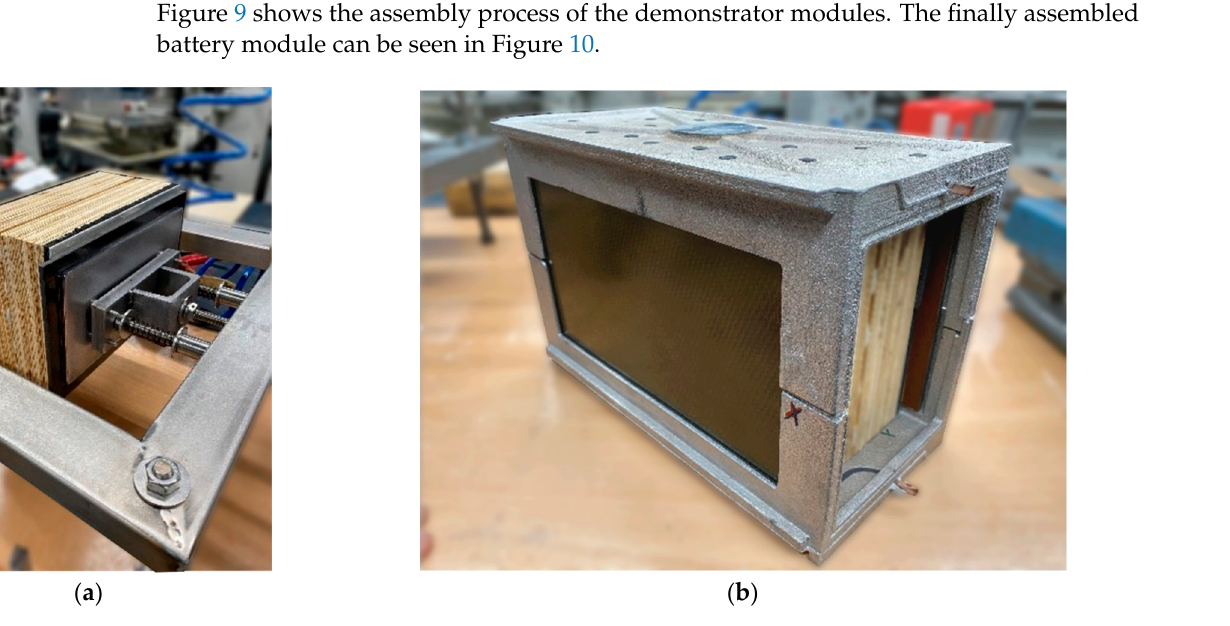
Figure 10. Demonstrator of the battery module. Left : rear view with window to provide insight into the module. Right : front view with stacked battery pouch cells and without cover. Dismantling of the lateral lightweight walls (e.g., at the end of use of the battery module to remove the pouch cells) can be carried out with the above-mentioned device.